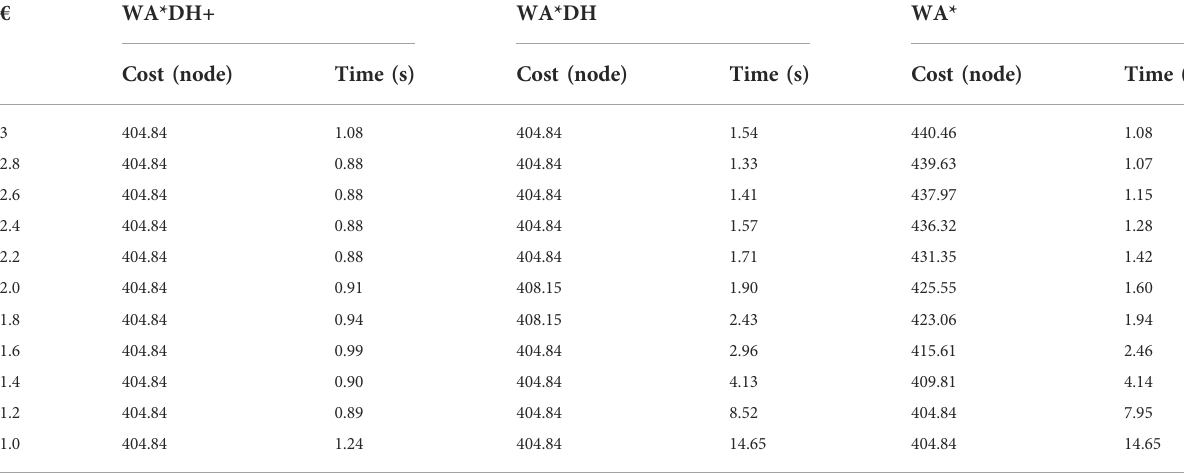
TABLE 2 Quantitative comparison of the performances of algorithms on simulation 1.